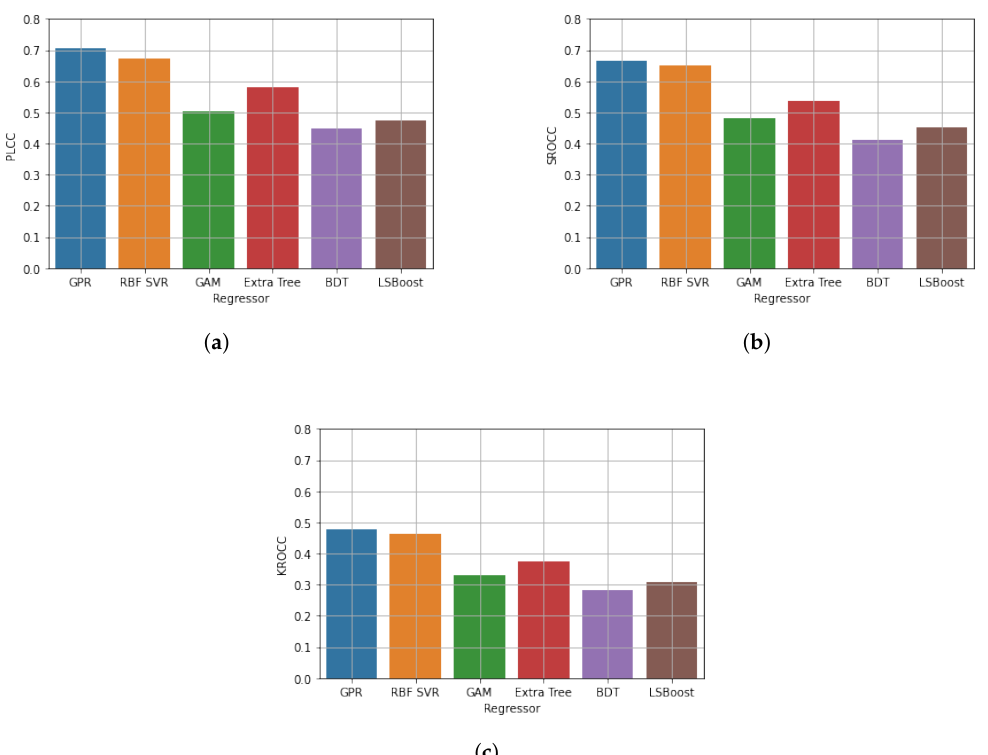
Figure 5. Comparison of different regression techniques (GPR, RBF SVR, GAM, extra tree, BDT, and LSBoost) in terms of median ( a ) PLCC, ( b ) SROCC, and ( c ) KROCC. Measured on CLIVE [10] over 100 random train-test splits.